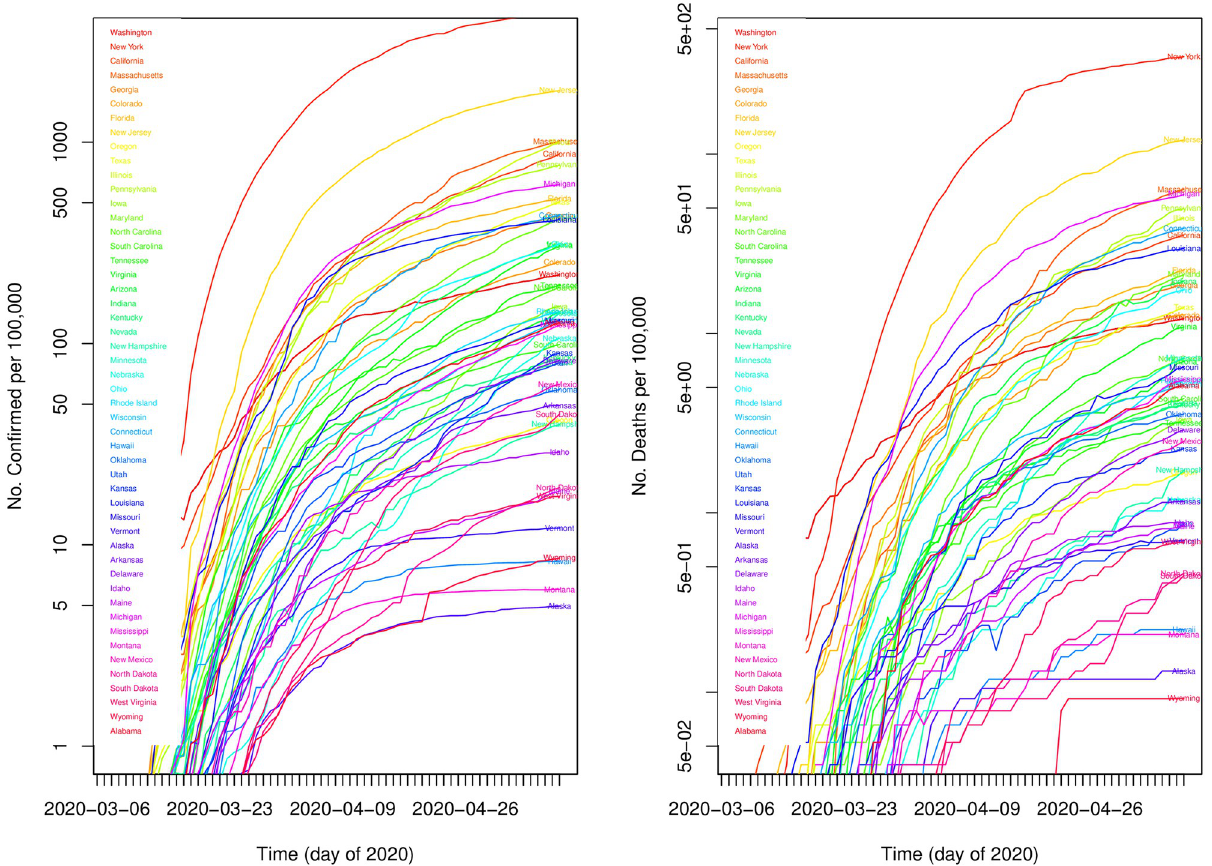
Fig 1. The variation of (Left) Cumulative number of confirmed cases per 100,000 for each state (colored arbitrarily to better separate each curve). (Right) Cumulative number of deaths per 100,000 for each state. Data runs from 2020–03-06 through 2020–05-10.